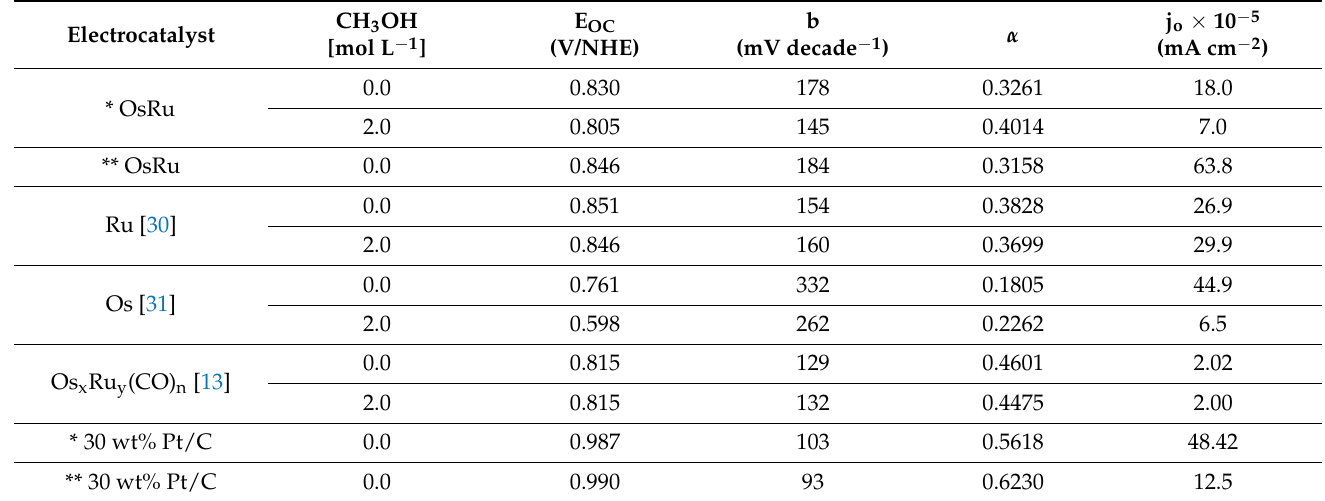
Table 5. Open circuit potential and electrokinetic parameters of the OsRu electrocatalyst for the oxygen reduction reaction (ORR) in the absence and presence of 2.0 mol L − 1 methanol solutions, in O 2 -saturated 0.5 mol L − 1 H 2 SO 4 , compared with the mono and bimetallic materials reported in literature and with 30 wt% Pt/Vulcan XC-72.